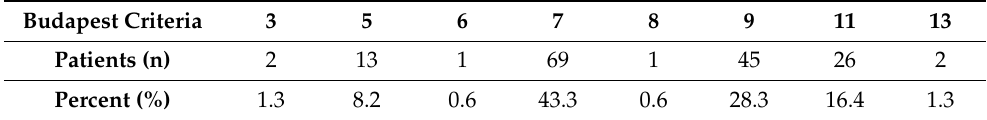
Table 4. The distribution of the Budapest